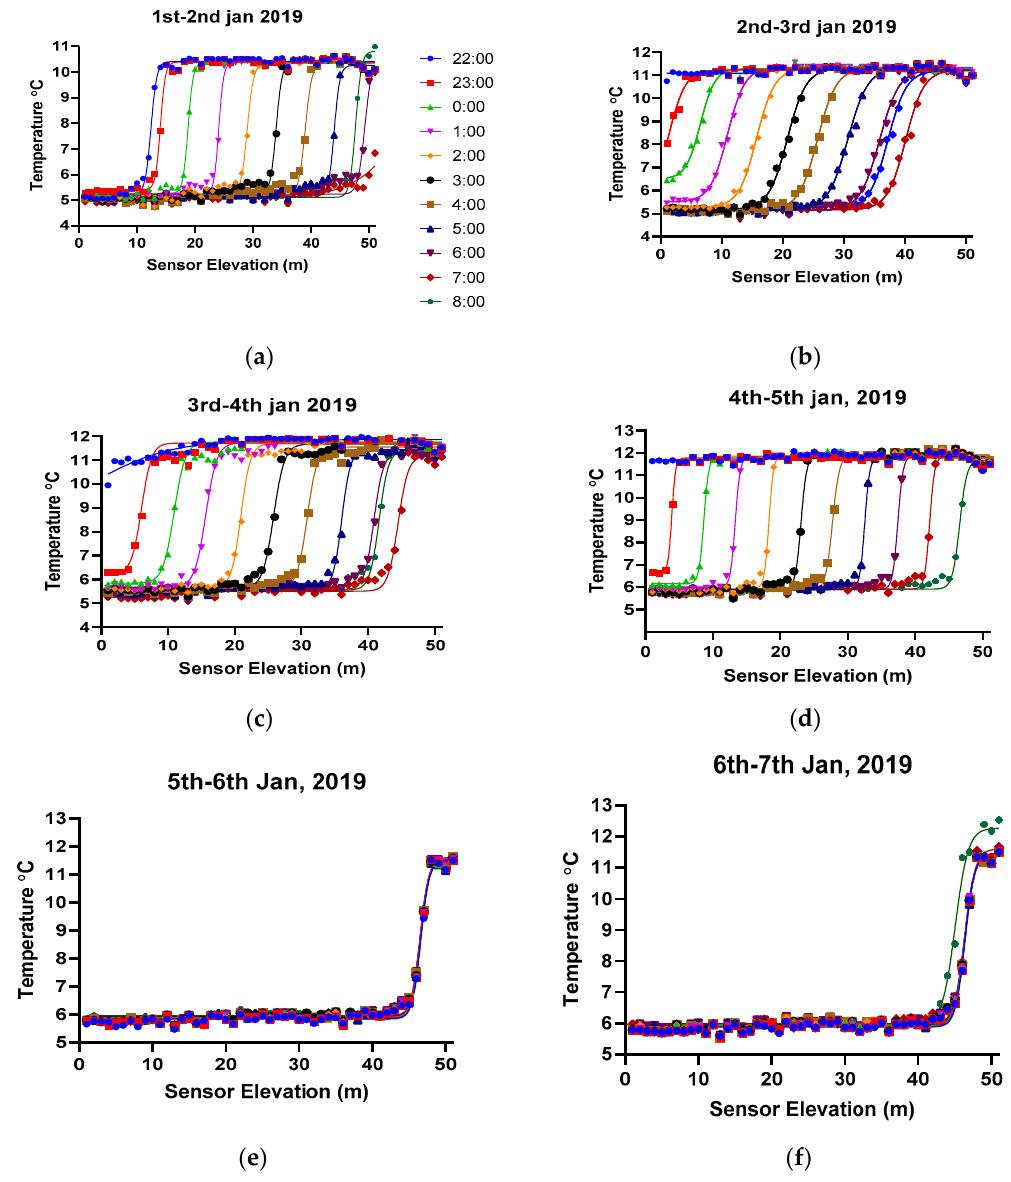
Figure 3. Temperature distribution plot for 1st–7th of January 2019 on GraphPad prism software. ( a – f ).